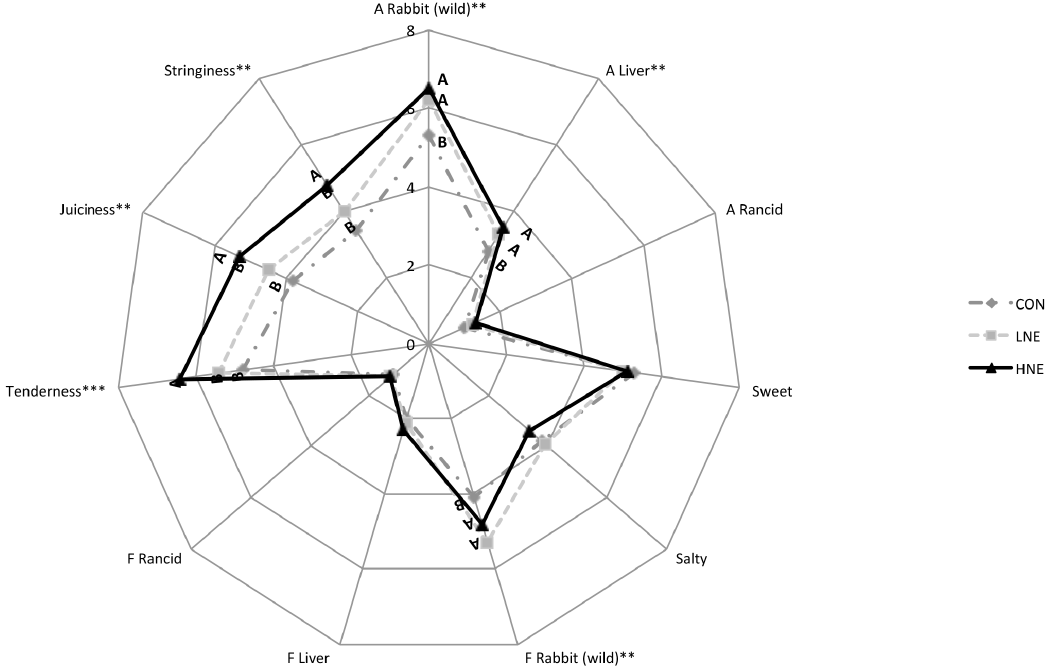
Figure 2. Sensory evaluation of Longissimus lumborum muscle in relation to dietary treatments. Groups: control group (CON); low natural extract (LNE); high natural extract (HNE). Significance: ∗∗ P < 0 . 01; ∗∗∗ P < 0 . 001; A: aroma; F: